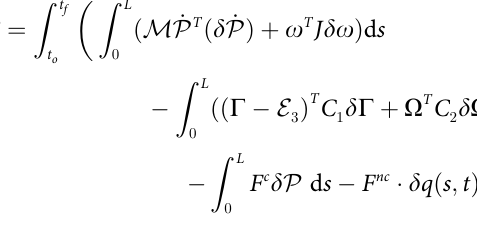
Table 2. Definition of parameters in Lagrangian (1) as described in [35]. M = ρ 0 × A ρ 0 and A are the body constant mass density and cross section’s area. o ð s ; t Þ 2 so ð 3 Þ the body angular velocity R d ð x E þ y E Þ 2 dxdy inertia matrix in the fixed frame J ¼ (cid:0) r 0 1 2 A (cid:0) ð O ð s ; t Þ ; G ð s ; t ÞÞ ¼ O (cid:0) 1 @ O ; O (cid:0) 1 @ P @ s @ s E , G = E /(2(1 + ν )), ν , I 1 , I 2 , and J